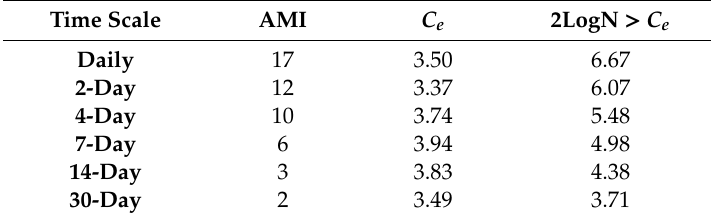
Figure 4. ( a ) Average mutual information for the daily value ( τ = 17); ( b ) reconstructed phase space by ( τ and 2 τ -day lag time).